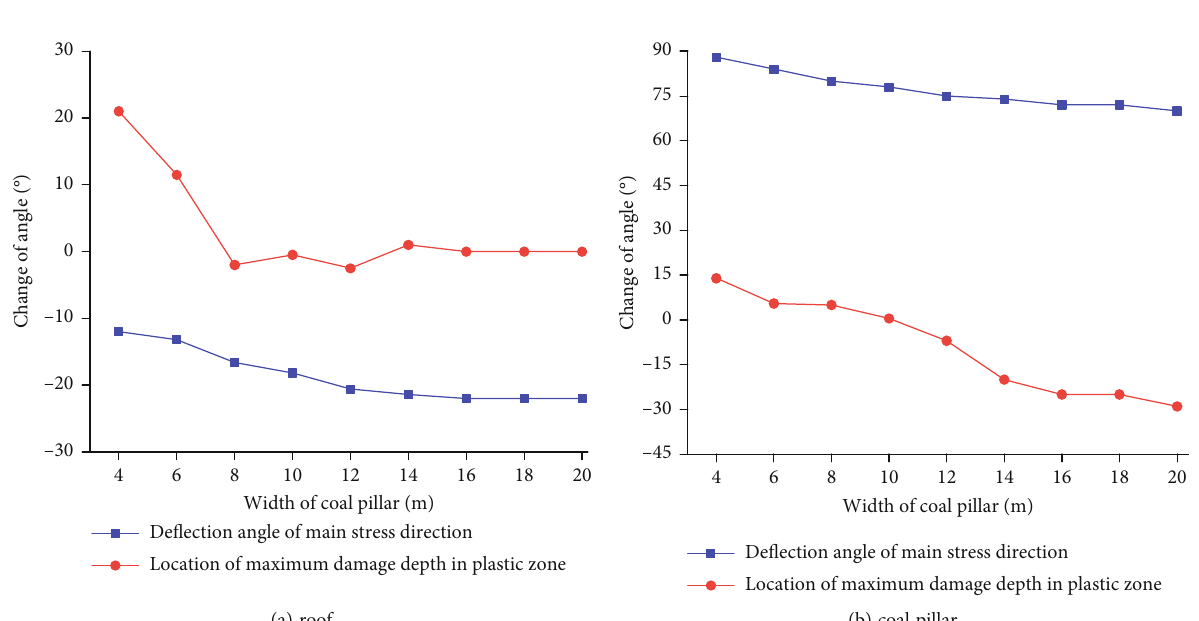
Figure 8: Curve of maximum failure depth position and principal stress direction in plastic zone of roadway surrounding